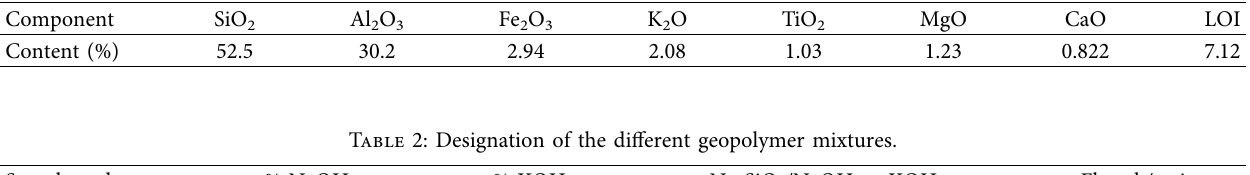
Table 1: Oxide percentages of the class F fly ash